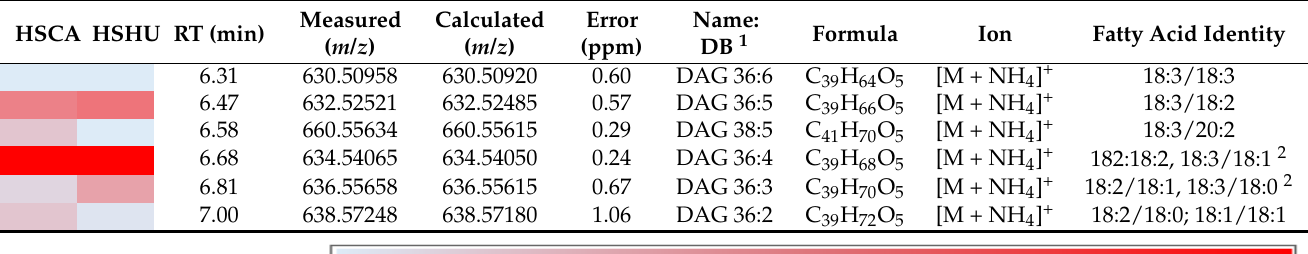
Table 2. Heat map of diacylglycerols (DAGs) identified in the polar lipid fraction (SPE-acetone fraction) of hemp cake (HSCA) and hemp seed hulls (HSHU).